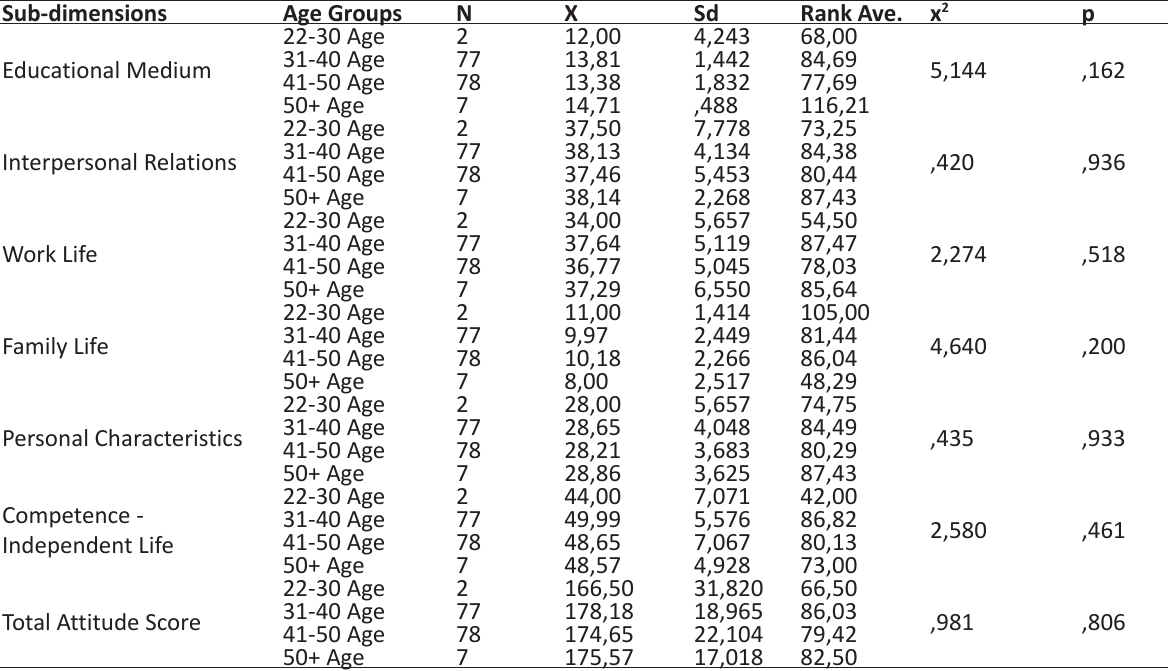
Table 4. Comparison of the Attitude towards the Handicapped Scores of the Participants according to the Age Groups Sub-dimensions